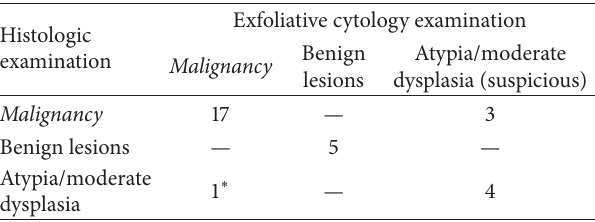
Table 2: Cross-table of the correlation between the results of the cytologic and histologic examination of 30 patients with precancer- ous or suspected malignant laryngeal